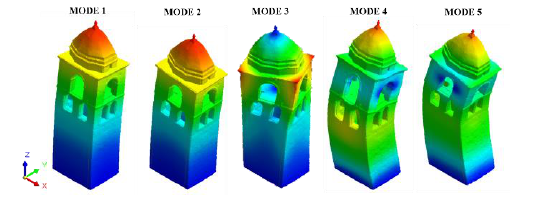
Figure 8. Numerical modal shapes of the starting numerical model